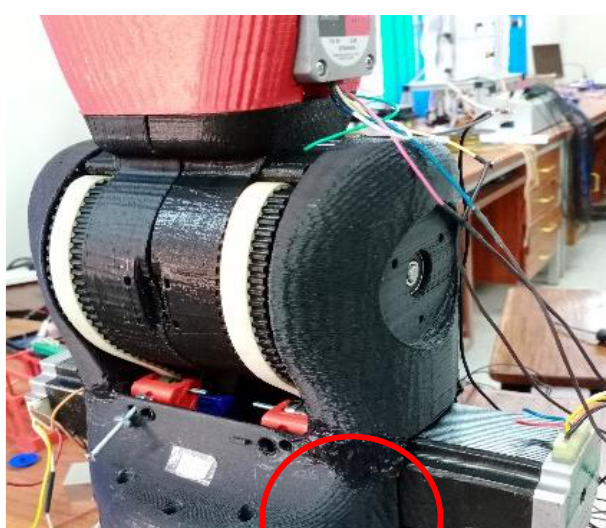
Fig. 8. RBX1 robotic arm.